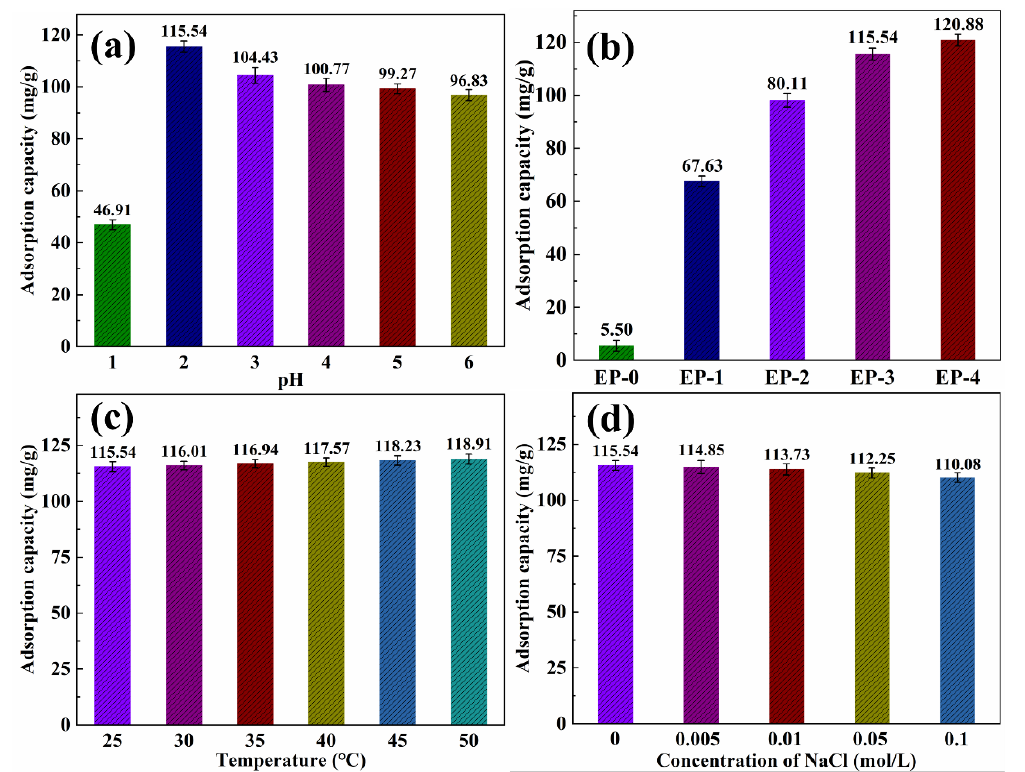
Figure 8. ( a ) Adsorption capacity of EP-3 for Cr(VI) under different pH values; ( b ) adsorption capacity of EVOH/PANI composite NFAs with various PANI nanorod contents for Cr(VI); ( c ) adsorption capacity of EP-3 for Cr(VI) under different temperatures; ( d ) adsorption capacity of EP-3 for Cr(VI) under different ionic strengths.